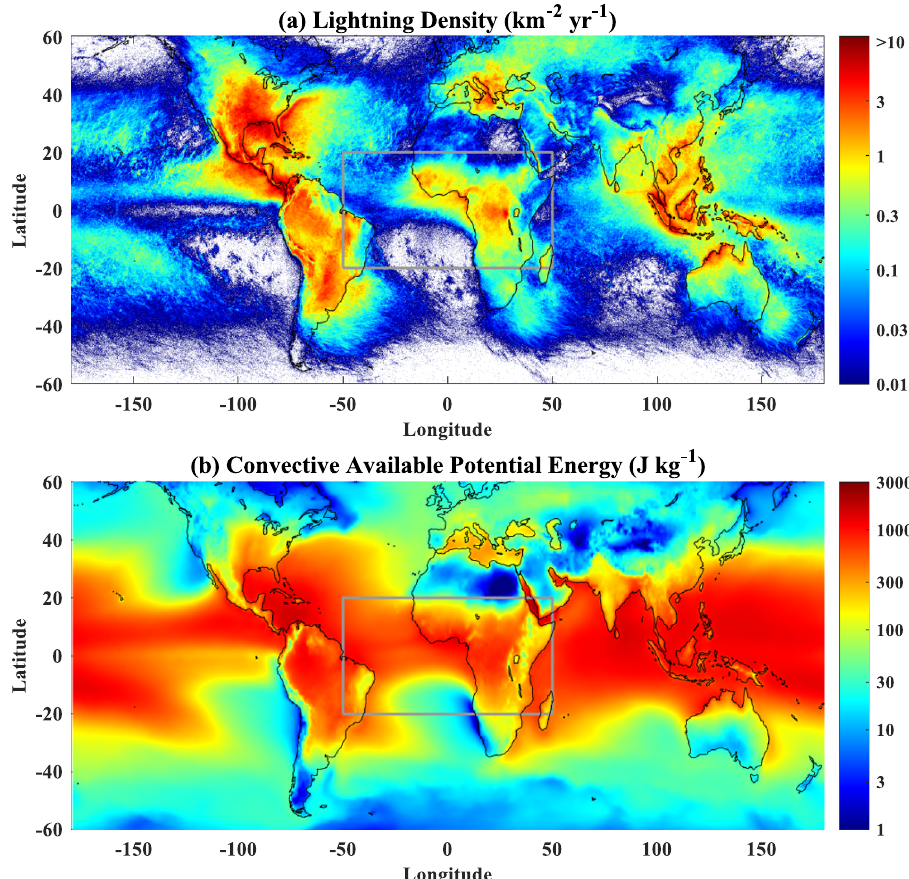
Fig. 1 Global distribution of lightning density and convective available potential energy (CAPE). The lightning density ( a ) and CAPE ( b ) are generated from World Wide Lightning Location Network (WWLLN) and National Centers for Environmental Prediction (NCEP) Final Operational Global Analysis data from 2013 to 2017. The gray rectangle indicates the region of interest from 50°W to 50°E and 20°S to 20°N.